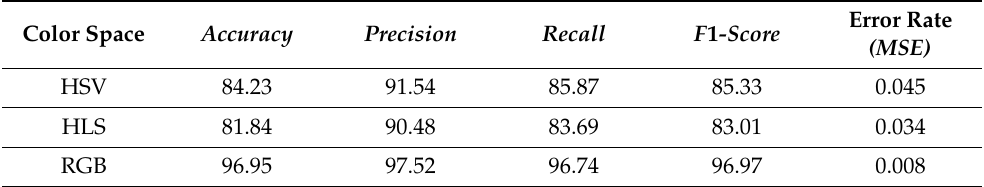
Table 5. Comparison of behavior classification performance according to color space.